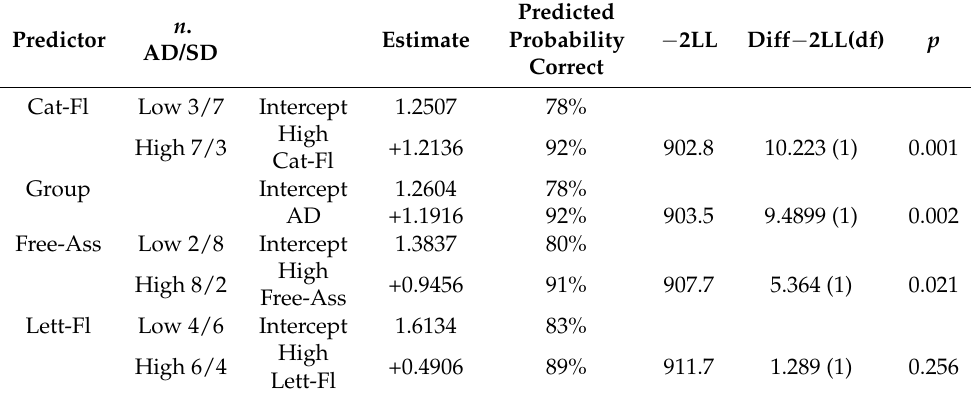
Table 2. Coefficients for mixed effects model contrasting the role of Group and Diagnostic tasks as unique